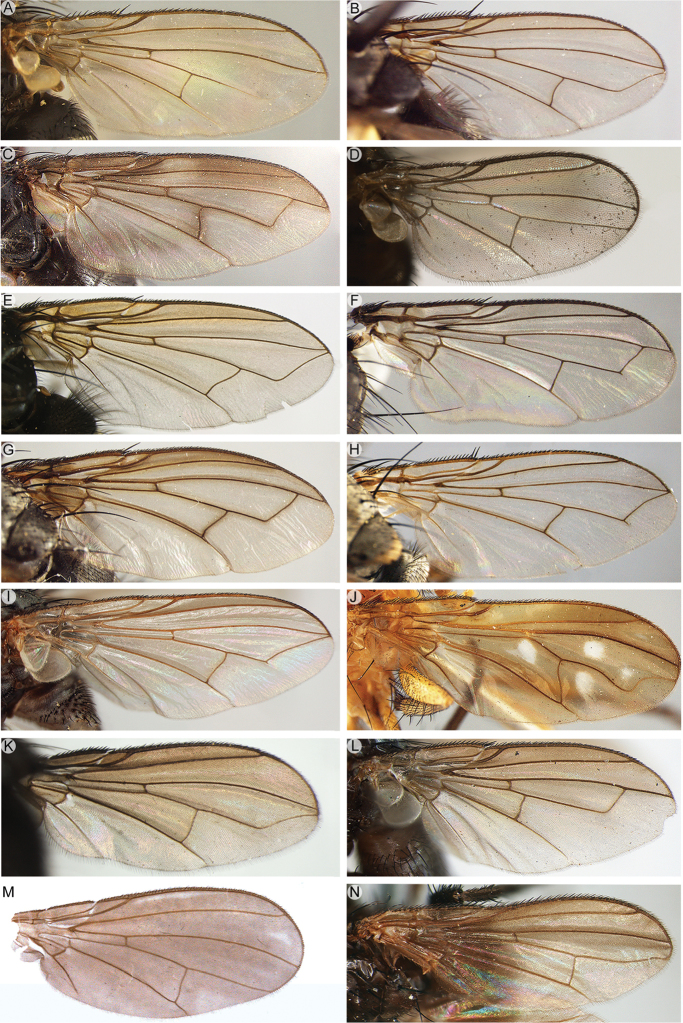
Rhinophoridae, wing. AOplisa
aterrima ♂ (Italy) BOplisa
tergestina ♂ (Italy) CPaykullia
partenopea ♂ (Italy) DRhinodonia
antiqua ♂ (New Caledonia) [holotype] ERhinomorinia
sarcophagina ♂ (Italy) FRhinophora
lepida ♂ (Italy) GStevenia
etrusca ♀ (Italy) [paratype] HTricogena
rubricosa ♀ (Morocco) ITromodesia
angustifrons ♀ (Israel) [paratype] JTrypetidomima
lutea ♂ (Brazil) KVentrops
milichioides ♂ (Tanzania) LVentrops
stuckenbergi ♂ (Namibia) [holotype] MRhinopeza
gracilis ♂ (Papua New Guinea) [holotype] NPolleniidae, wing: Morinia
carinata ♂ (South Africa).